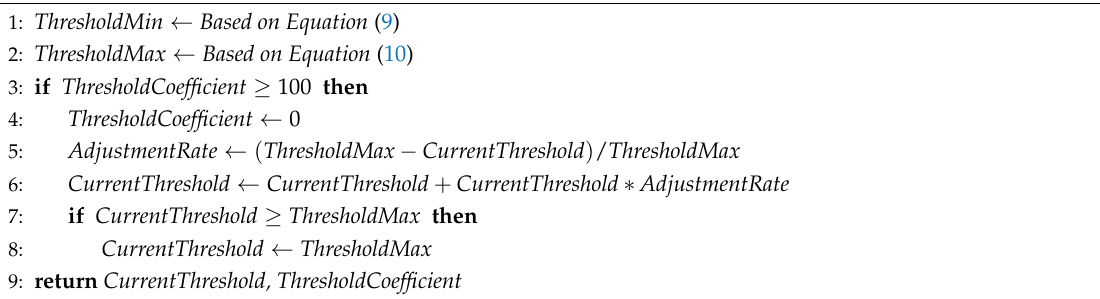
Algorithm 2 Resource-Aware Optimal Threshold Selection